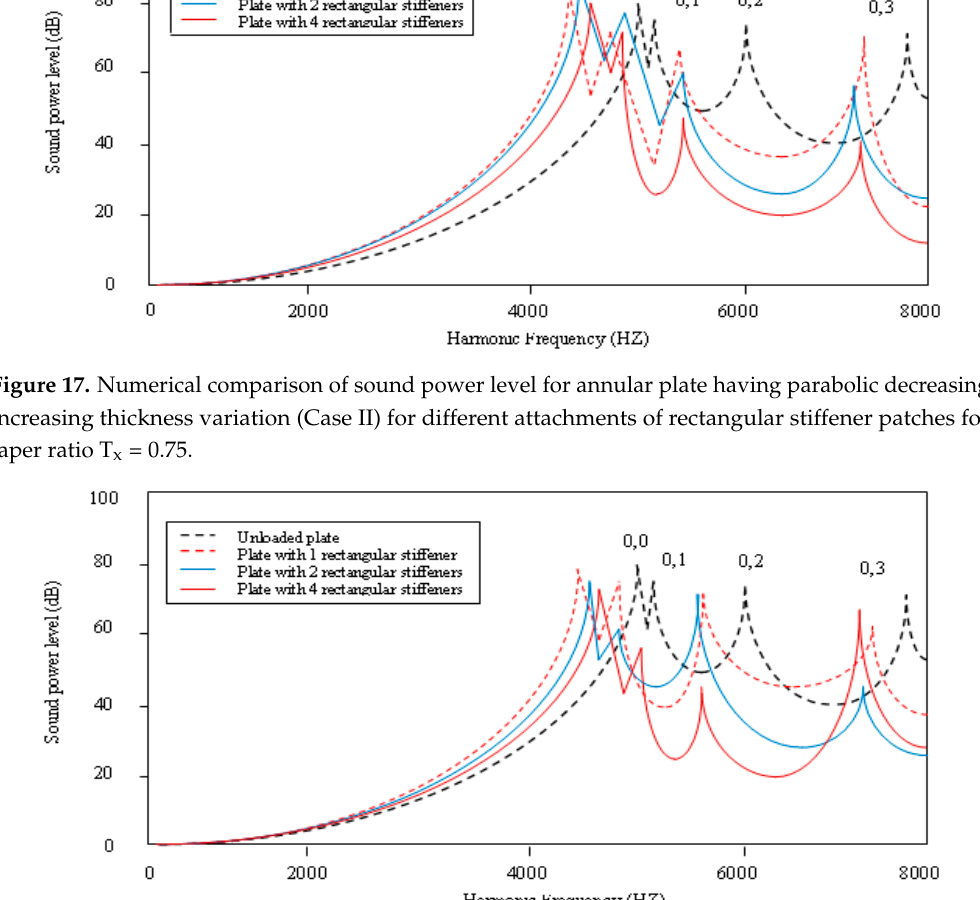
Figure 20. Numerical comparison of sound power level for annular plate having parabolic decreasing increasing thickness variations (Case II) for different combinations of concentric stiffener patches for taper ratio T x = 0.75.